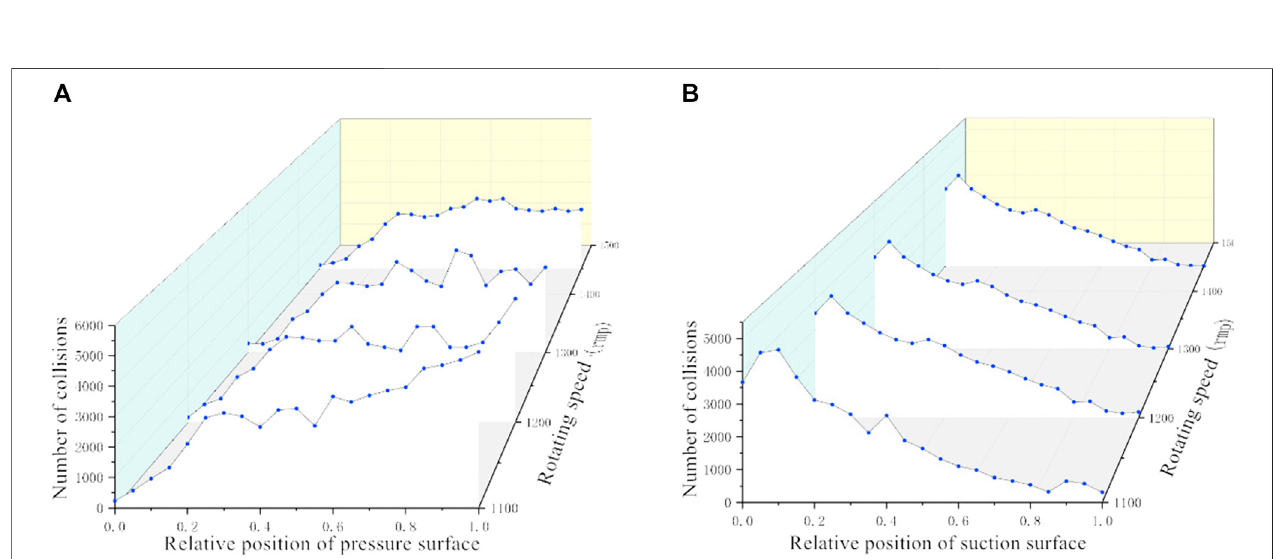
FIGURE 8 | Number of particle collisions on the pressure and suction surfaces of the space guide vane blade.